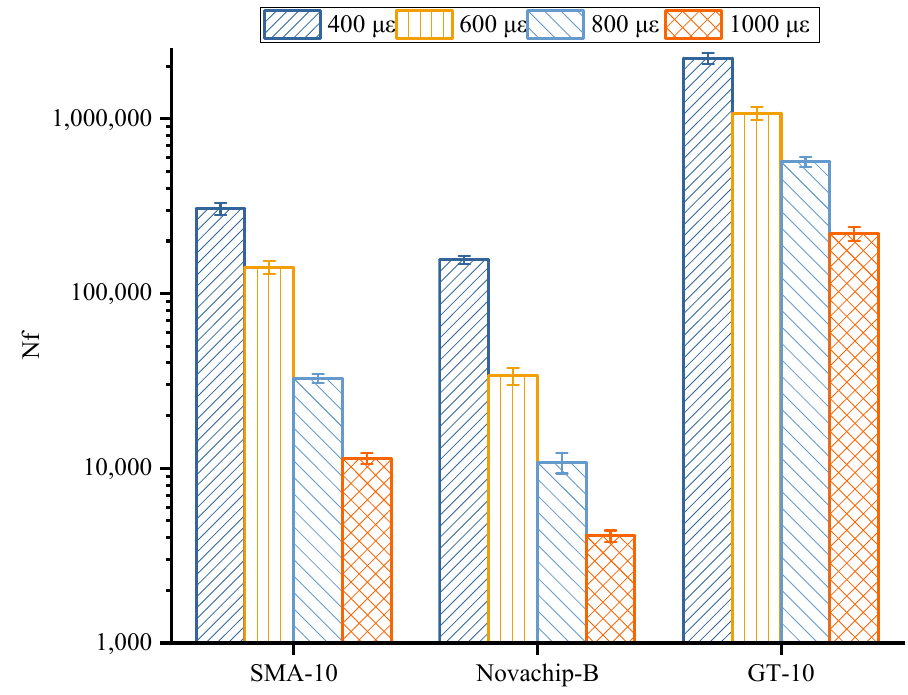
Table 7. Results of four points bending fatigue test.